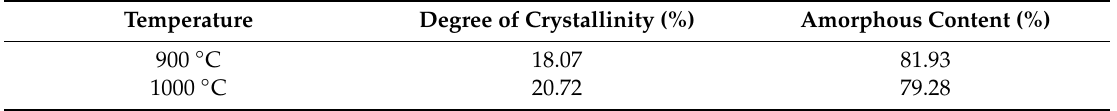
Figure 9. XRD spectra for MBC at 900 ◦ C vs. 1000 ◦ C ( A ) and MBC at 1000 ◦ C vs. background ( B ). Table 2. Degree of crystallinity and amorphous content of MBC.